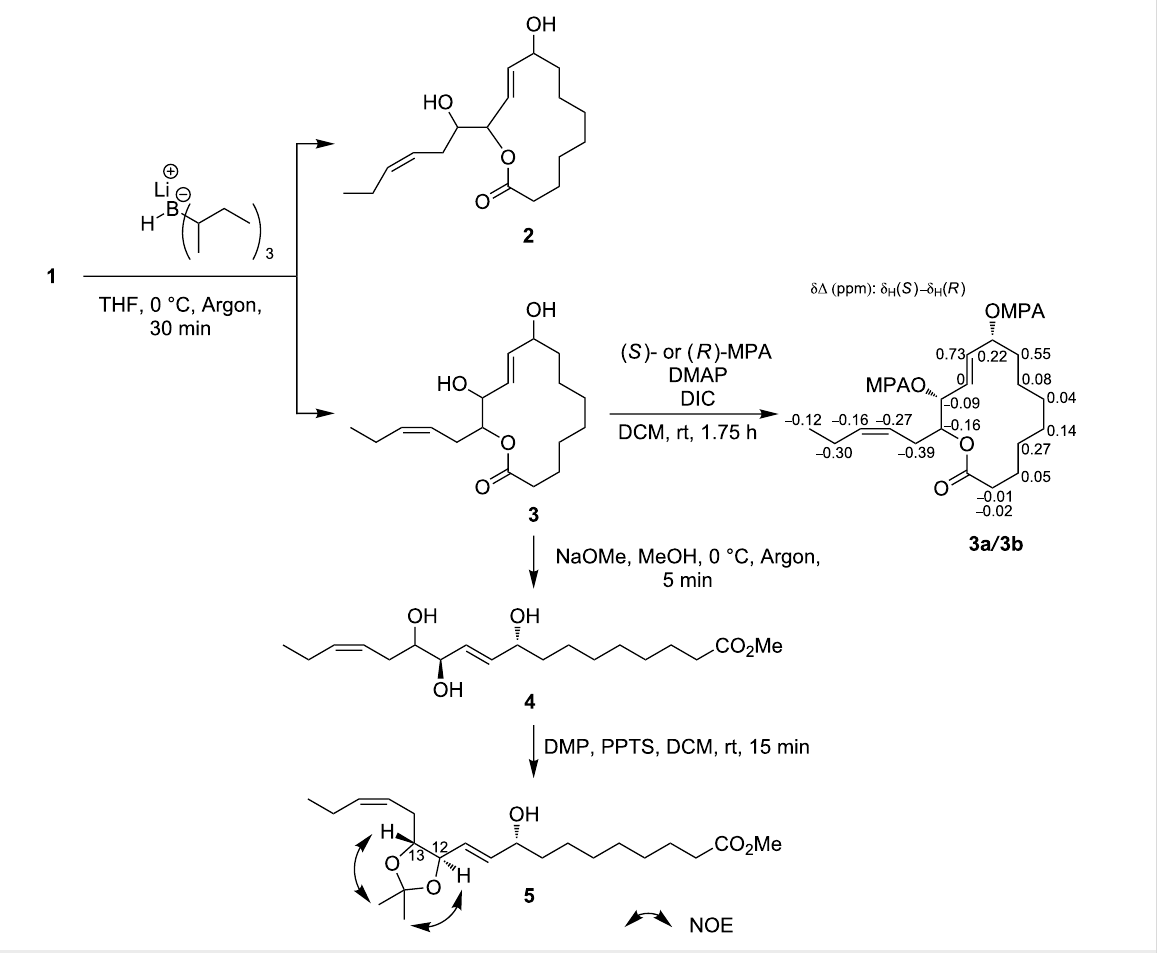
Scheme 2: Determination of the stereochemistry of sacrolide A ( 1